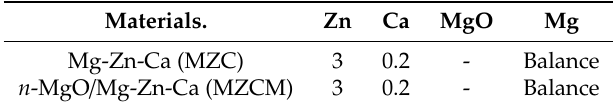
Table 1. The chemical components of the Mg-3Zn-0.2Ca alloy (MZC) and the 0.2MgO / Mg-3Zn-0.2Ca composite (MZCM)